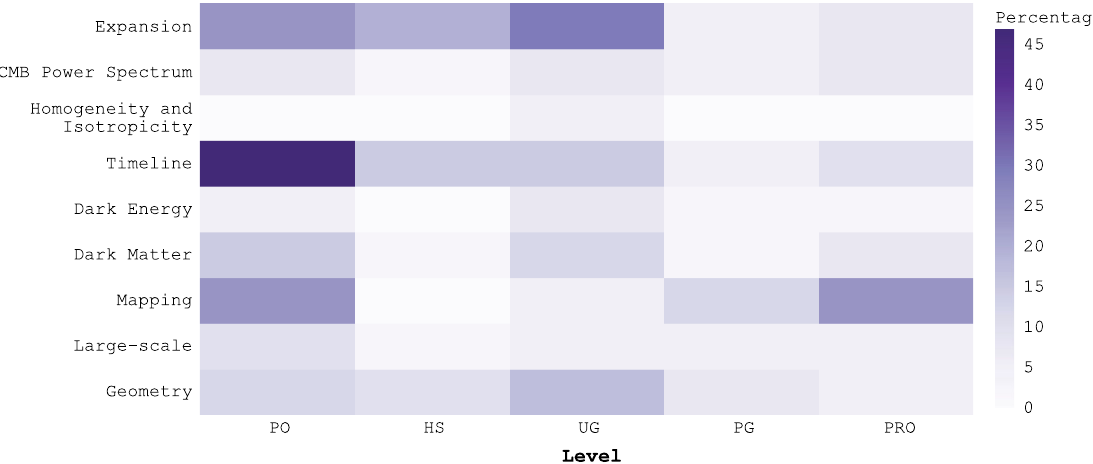
FIG. 10. A visualization showing the distribution of representations communicating specific concepts in cosmology at each of the target audience levels (public outreach, high school, undergraduate, postgraduate, and professional), as a percentage of the total number of representations n ¼ 247 . The darker shades represent higher